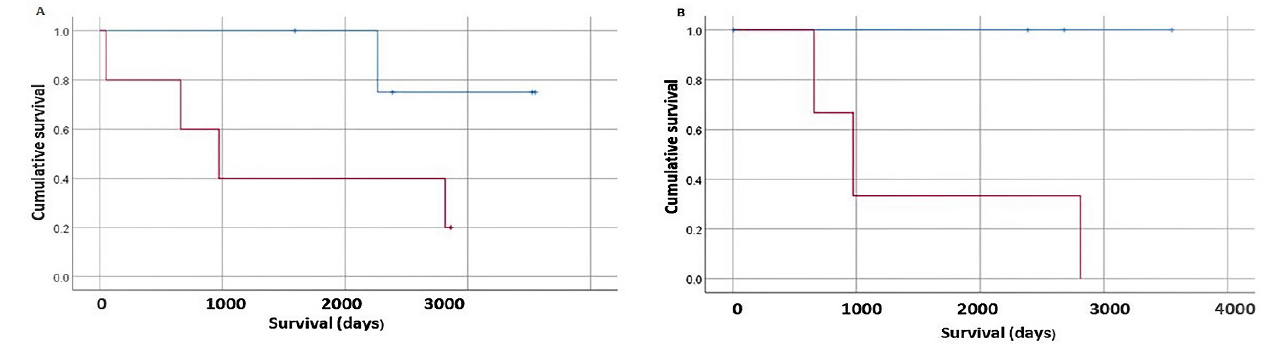
Figure 2. Survival analysis based on Treg surrogate markers. ( A ), Kaplan–Meier analysis of OPMD/OSCC patients stratified by first vs. fourth quartile of CD25 staining. The red line represents the highest quartile CD25 detected, and the blue line represents the lowest quartile of CD25 detection. The survival difference did not reach statistical significance—Mantel–Cox Log Rank test p = 0.092. ( B ) Kaplan–Meier analysis of OPMD/OSCC patients stratified by first vs. fourth quartile of FoxP3 staining. The red line represents the highest quartile FoxP3 detected, and the blue line represents the lowest quartile of FoxP3 detection. The survival difference did not reach statistical significance—Mantel–Cox Log Rank test p = 0.063.